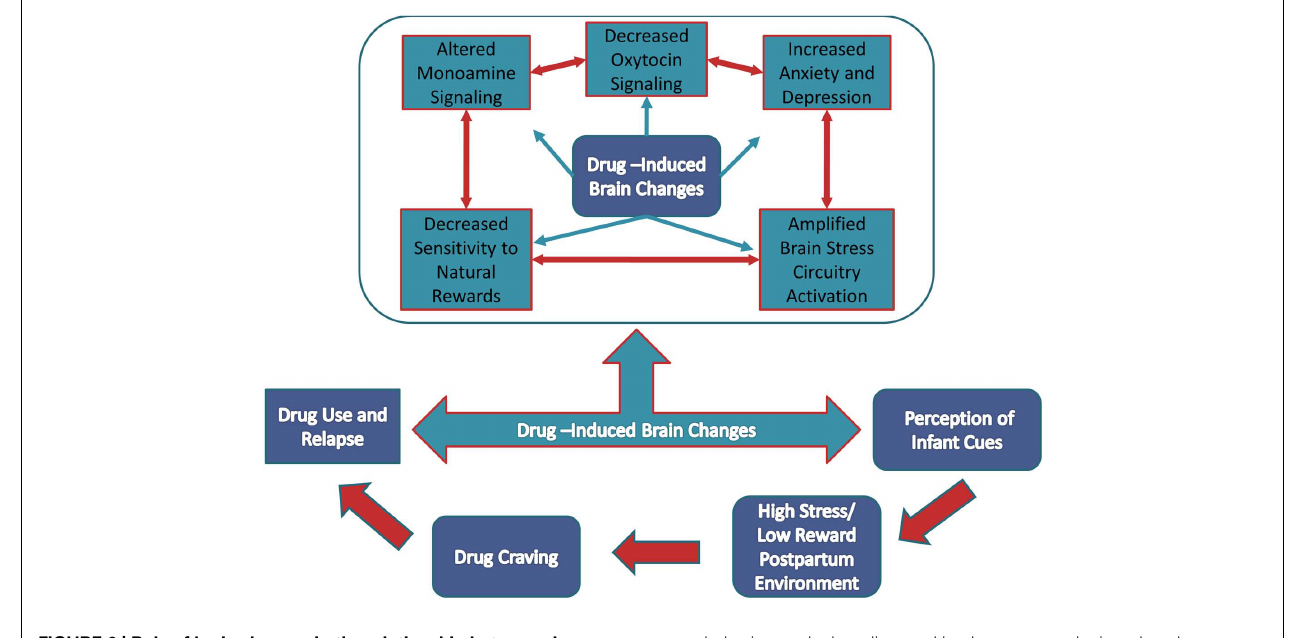
FIGURE 6 | Role of brain changes in the relationship between drug use and parenting. Drug use is known to cause a number of brain changes (teal boxes and arrows).These changes can influence each other (red double-tipped arrows) by either amplifying or diminishing alterations depending on the behavioral and biological context. Importantly, these changes have independently been shown to contribute to parental